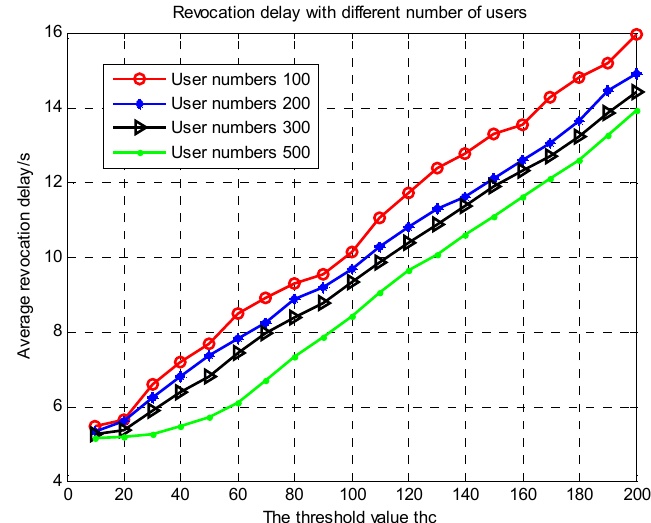
Figure 3. Revocation delay with different numbers of users.